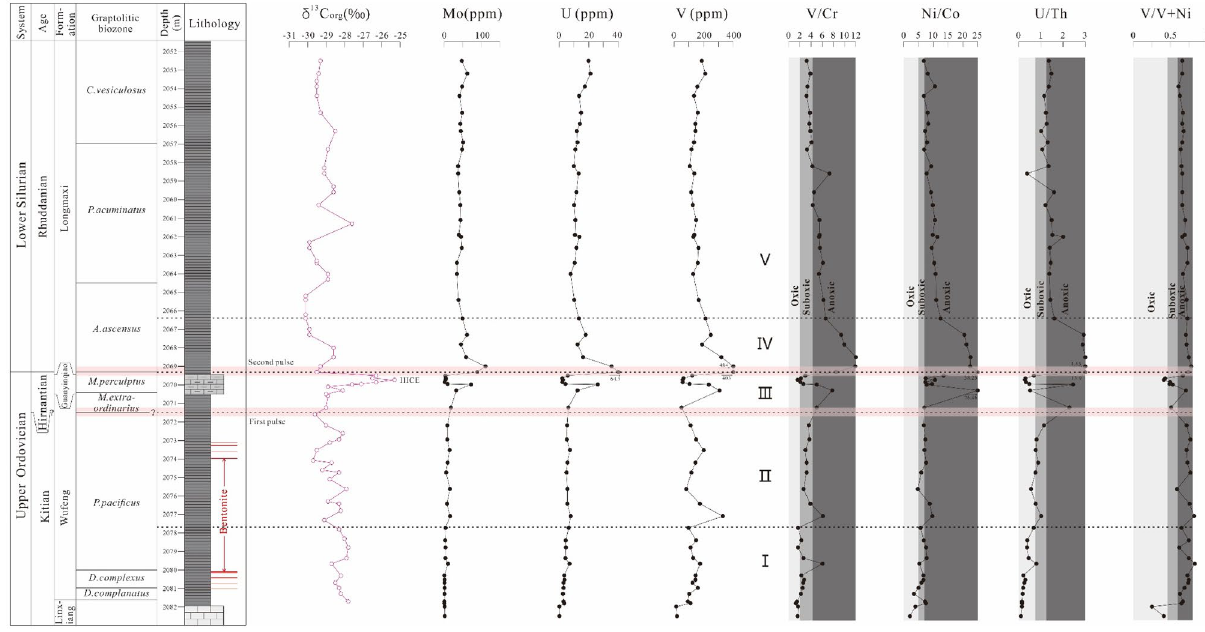
Figure 14. Stratigraphic variations in palaeoredox proxies for the Xindi No. 2